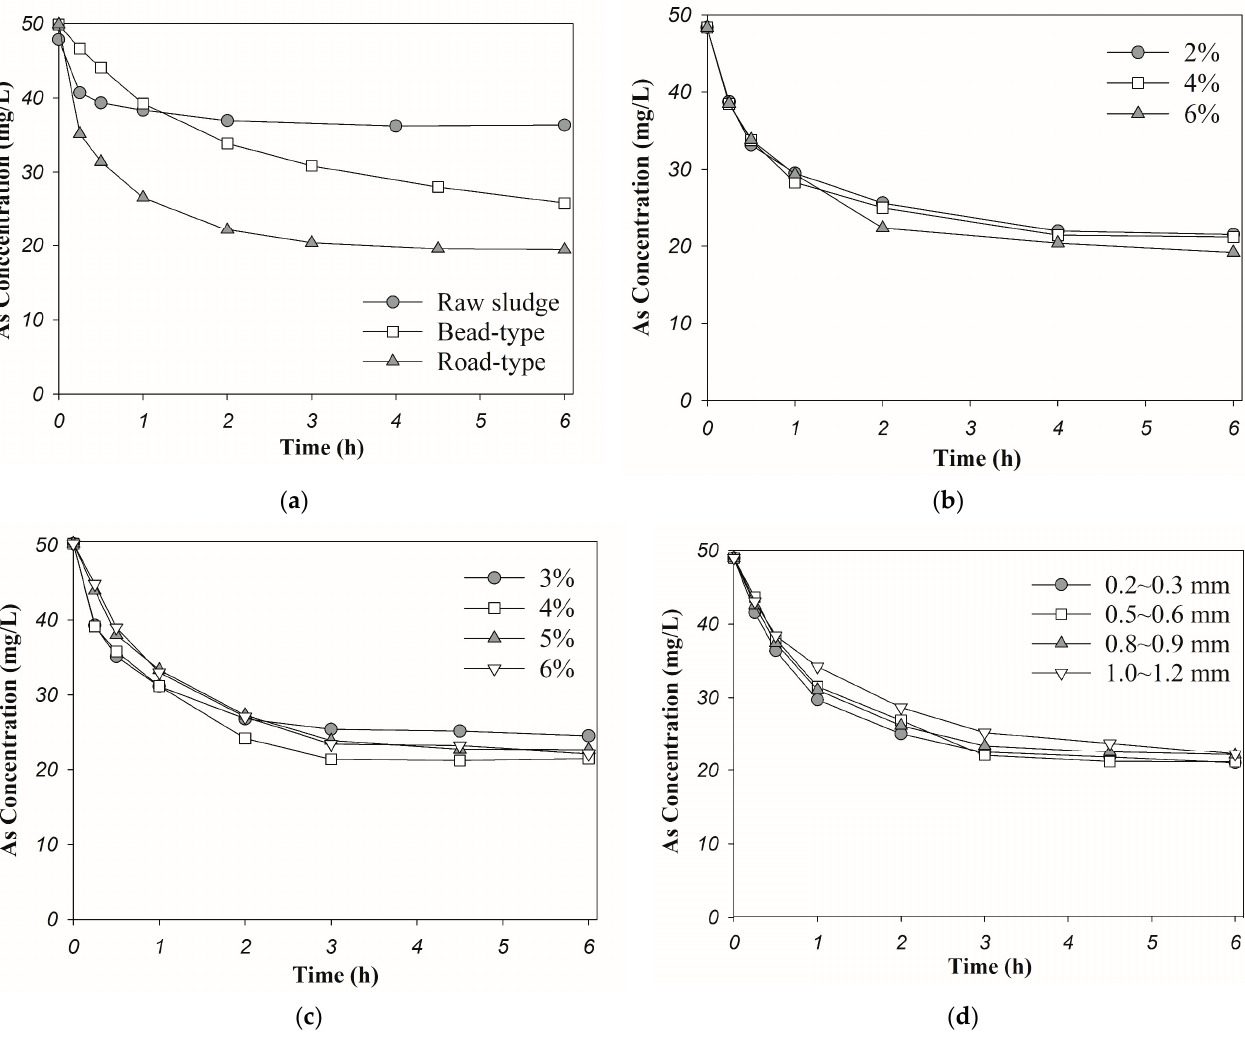
Figure 1. Effect of ( a ) biosorbent shape, ( b ) chitosan content, ( c ) sludge content, and ( d ) biosorbent size on the adsorption of As(V) on the sludge–chitosan (biosorbent dosage = 2 g/L, agitation rate = 200 rpm, contact time = 6 h, temperature = 25 °C, Vw = 200 mL, and pH non shift (pH 5.5)).